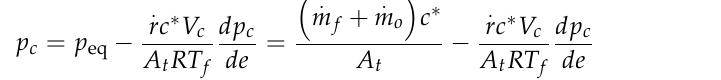
Figure 7. Flowchart of LV